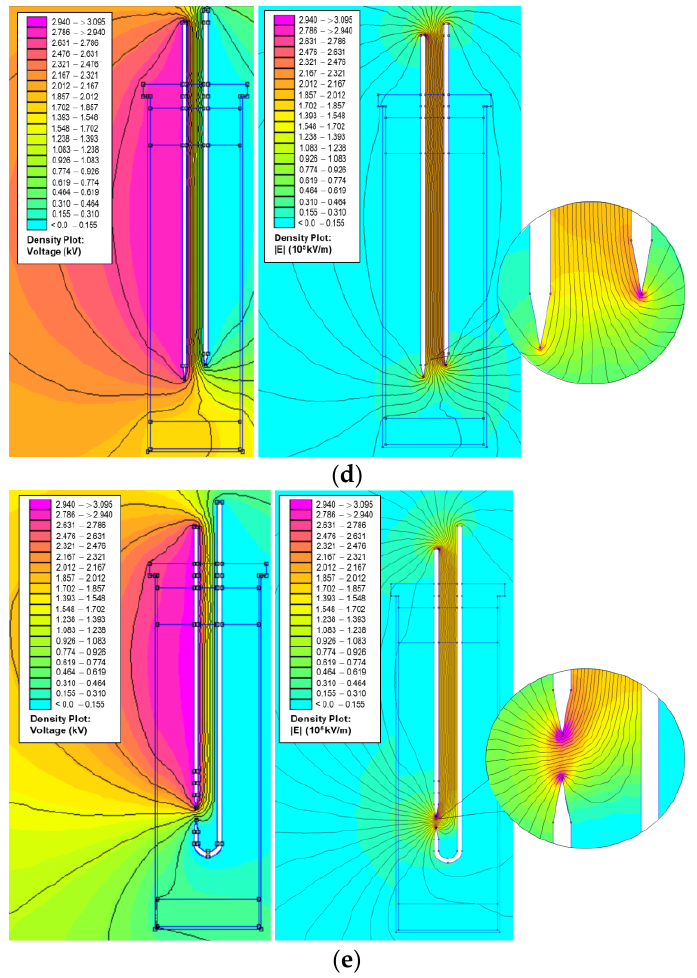
Figure 12. FEMM simulation results of electric field strength distribution with density plots in voltage (V) and electric field strength (V/m) of iron (Fe) electrodes with different electrode configurations and applied AC voltage of 3 kV: ( a ) bar electrodes at the same level; ( b ) bar electrodes at different level with vertical distance between electrodes of 3 cm; ( c ) point electrodes at the same level; ( d ) point electrodes at different level with vertical distance between electrodes of 3 cm; and ( e ) point-to-point electrodes with vertical distance between electrodes of 3 cm.